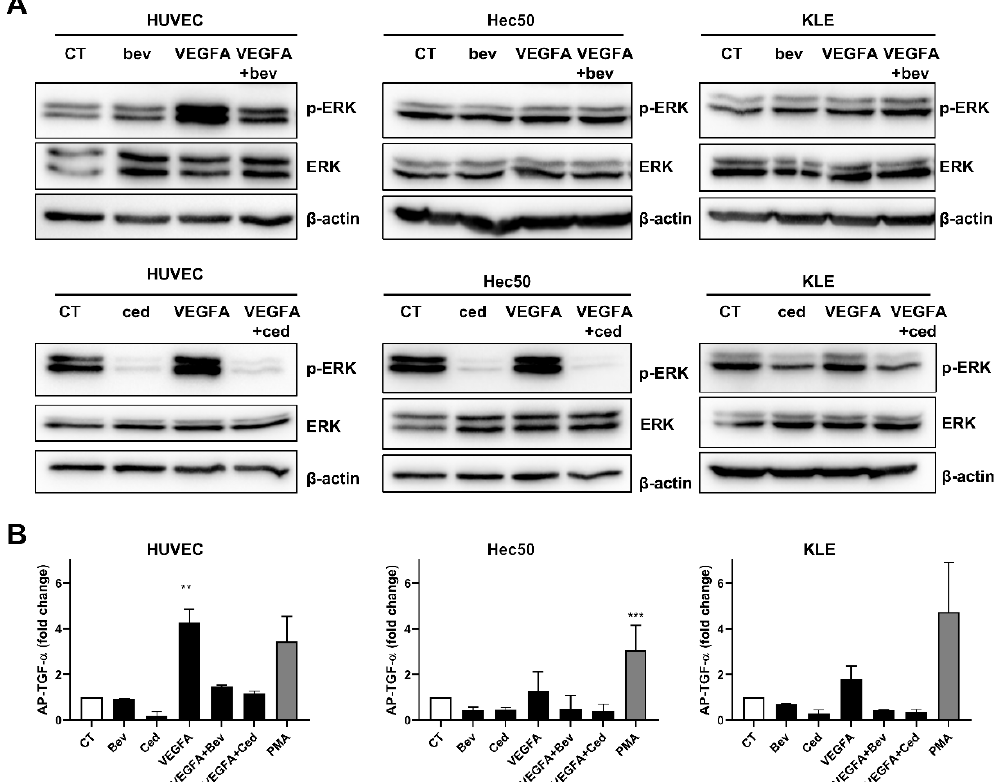
Figure 1. Impact of bevacizumab and cediranib on VEGFR signaling endothelial cells and endometrial cancer cells. ( A ) HUVEC, Hec50, and KLE cells were treated with vehicle control (CT), 1 µM bevacizumab (Bev), 100 ng/mL VEGF-A, or 1 µM cediranib (Ced) for 1 hr, followed by assessment of ERK1/2 phosphorylation at Thr202/Tyr204 or total ERK expression by Western blotting. β -actin: loading control. ( B ) Cells were transfected with the alkaline phosphatase (AP)-tagged ADAM17 substrate TGF- α , and treated as in ( A ) for 1 hr. The change in soluble AP-TGF- α was assessed and presented as fold change compared to control (CT). PMA (25 ng/mL) served as a positive control for induction of AP-TGF- α shedding. ** p < 0.01; *** p < 0.001 versus CT by one-way ANOVA with Tukey’s multiple comparisons test.